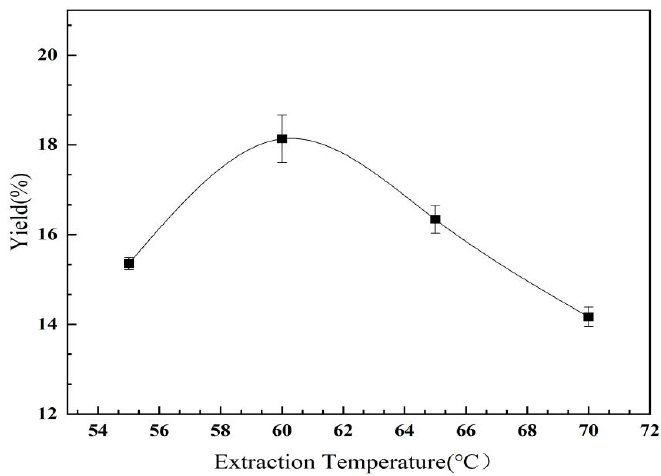
Figure 5. Influence of extraction temperature on yield of C. oleifera saponins (liquid–solid ratio = 3.5:1; methanol concentration = 75%; extraction time = 180 min).